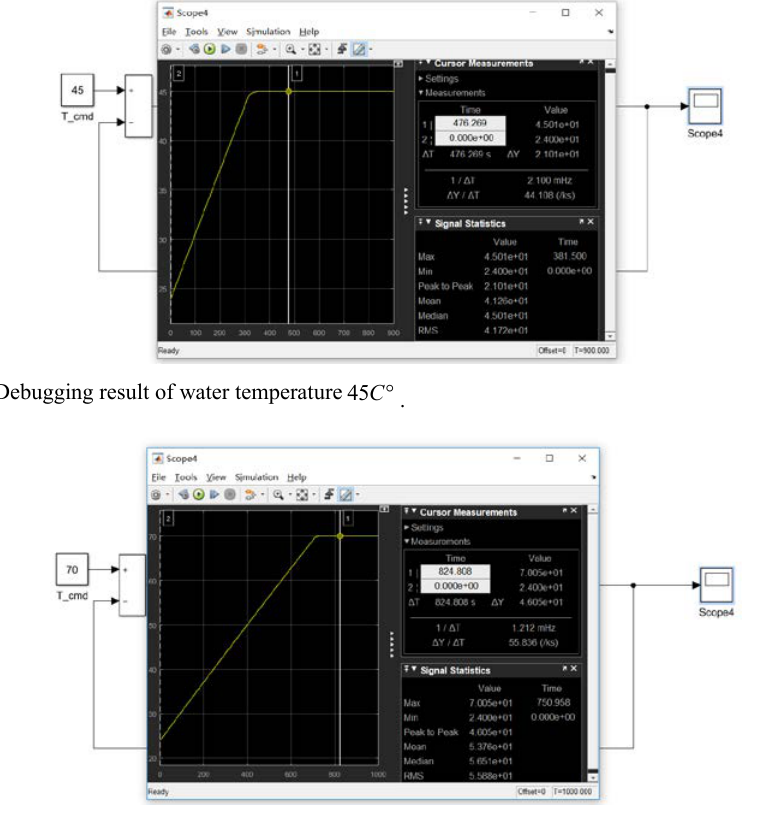
Fig. 8. Debugging result of water temperature 70 C °